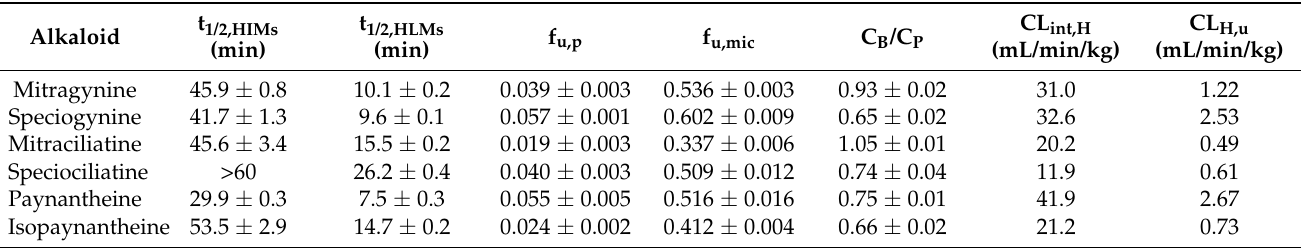
Table 3. In vitro metabolism, protein binding, and blood-to-plasma concentration ratio data for kratom alkaloids.